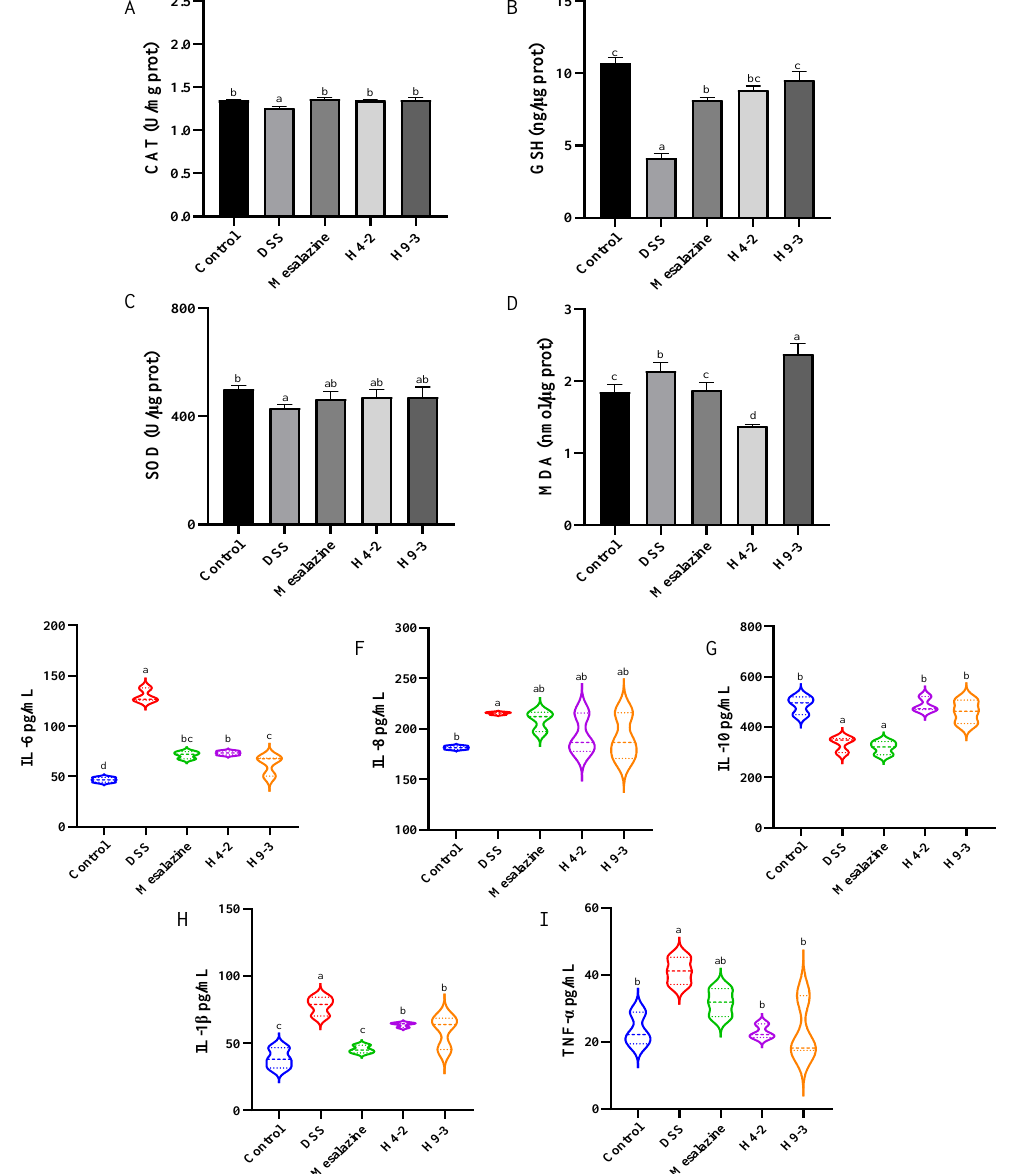
Figure 5. Changes of serum and colon biochemical functions in colitis mice after intervention with B. breve . Levels of CAT ( A ), GSH ( B ), SOD ( C ), and MDA ( D ) in serum; levels of IL-6 ( E ), IL-8 ( F ), IL-10 ( G ), TNF- α ( H ) and IL-1 β ( I ). Different lowercase letters (a, b, c, d) above the columns indicate significant differences ( p < 0.05), and the same superscript letters indicate that the differences between the values are not statistically significant ( p > 0.05).